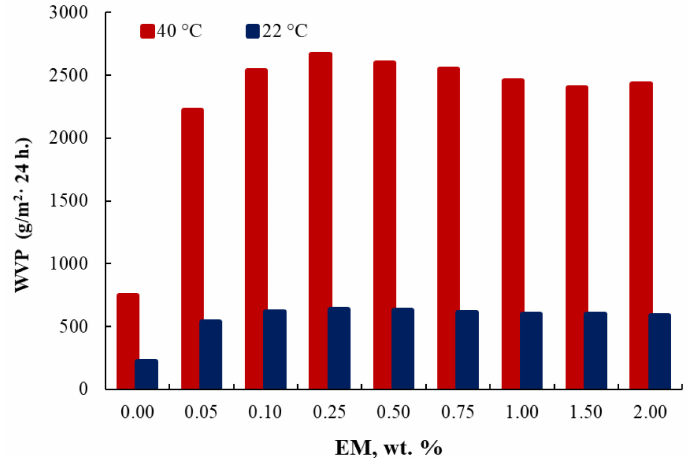
Figure 8. Dependences of the water vapor permeability coefficients at 22 ◦ C and 40 ◦ C for AEBA-PU and AEBA-EM-PU on the content of EM in AEBA-EM,